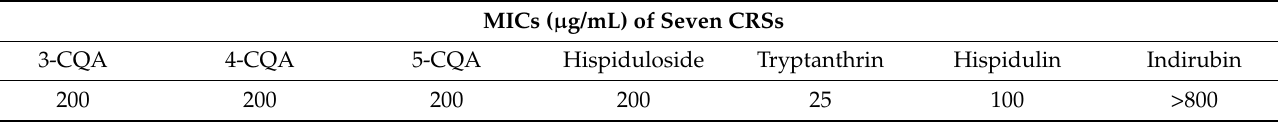
Table 3. Anti-PRSP effect of seven Chemical Reference Substances (CRSs).